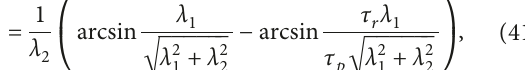
Figure 4: The full bolt/grout interface is composed of the elastic section and softening section in the elastic-softening